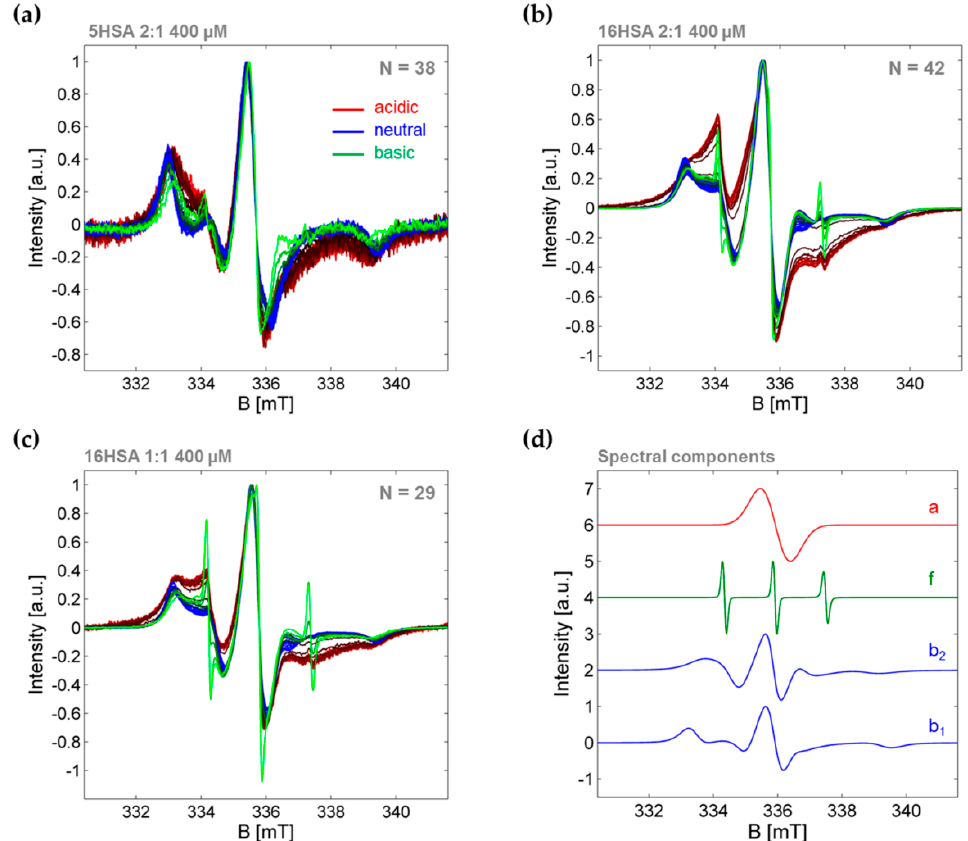
Figure 3. CW EPR experiments on spin probed HSA depending on pH. Here, CW EPR spectra are shown of 5 ‐ and 16 ‐ DSA ‐ probed HSA solutions between 0.81 < pH < 12.87. All pH ‐ dependent spectra are color coded in red (acidic), blue (neutral or compact) and green (basic) in overlapping graphs of N spectra. ( a ) All experimental CW EPR spectra of 5 ‐ DSA ‐ probed HSA solutions are shown in the range of 0.81 < pH < 12.20 ( N = 38) loaded with two equivalents spin probe (2:1). ( b ) All CW EPR spectra of 16 ‐ DSA ‐ probed HSA solutions are shown in the range from 0.89 < pH < 12.24 ( N = 42, 2:1). ( c ) CW EPR spectra of 16 ‐ DSA ‐ probed HSA solutions are shown in the range from 0.98 < pH < 12.87 ( N = 29, 1:1). All samples were recorded at 25 °C and 400 μ M equivalents of protein to spin probe. ( d ) Some exemplary simulations of 16 ‐ DSA interacting with HSA (see Supplementary Material S4) are shown from the most prominent spectral features of aggregates ( a , red), free ligand ( f , green) and bound ligand ( b 1 , b 2 , blue) that dominate the spectral shape at specific pH ranges.